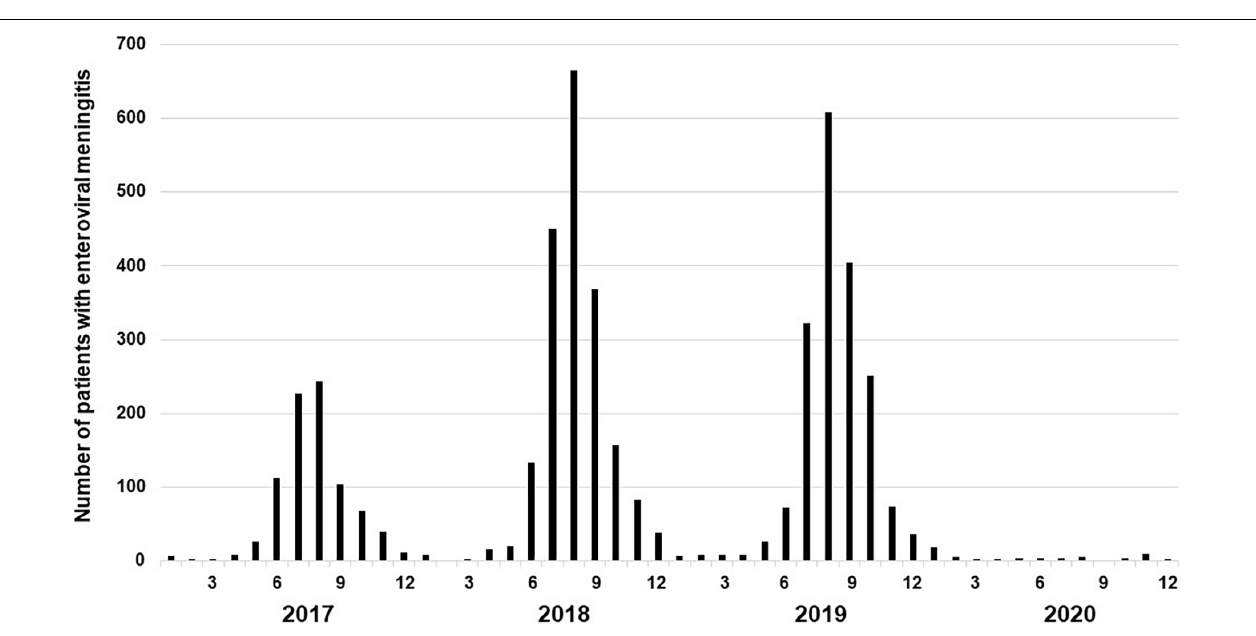
FIGURE 4 | Monthly frequency distribution of enteroviral meningitis included in the sentinel surveillance system of the Korea Disease Control and Prevention Agency (KDCA) between January 2017 and December